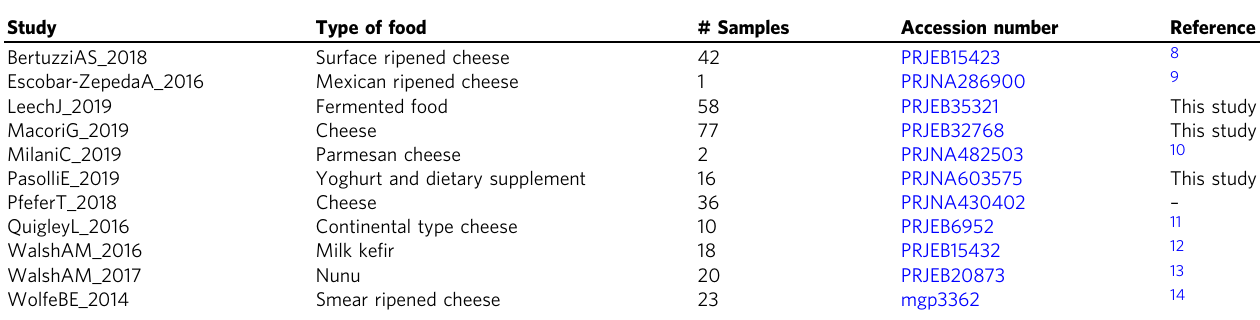
Table 1 Summary of the analysed food metagenomic